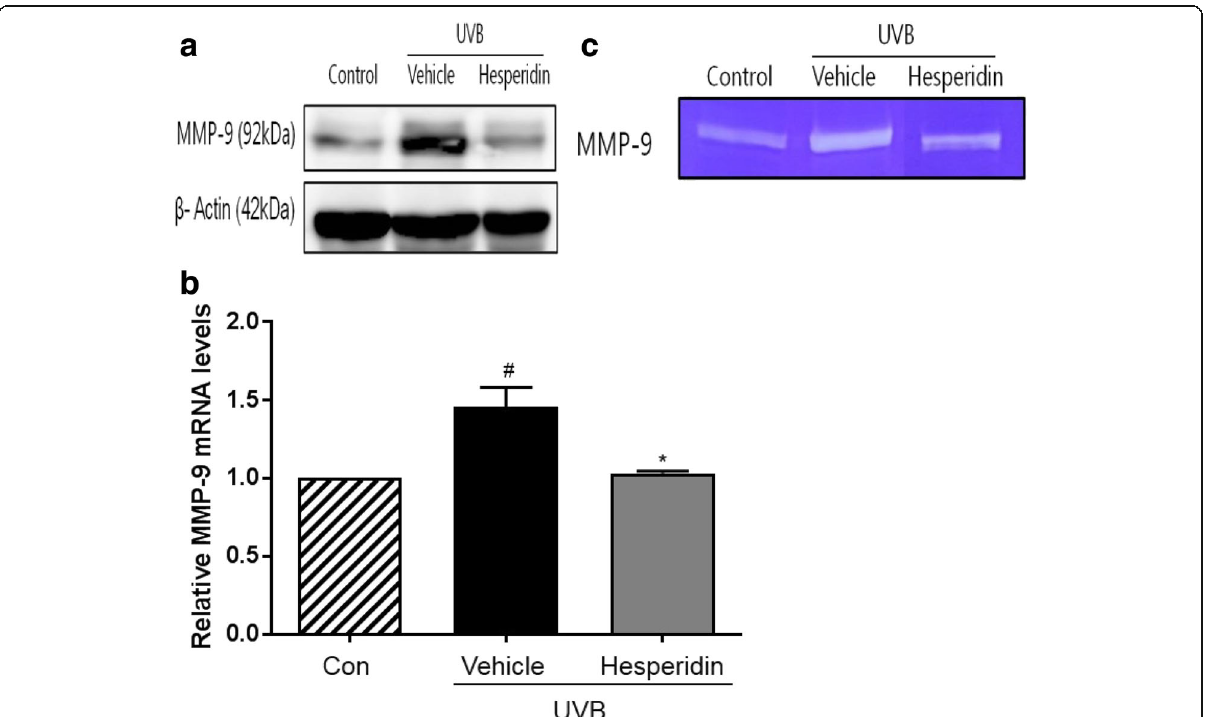
Fig. 4 Inhibitory activity of hesperidin on the UVB-induced MMP-9 protein expression and enzyme activity in the photoaged hairless mice model. ( a ) Inhibition of the UVB-induced MMP-9 protein expression by hesperidin. The MMP-9 levels were determined by western blotting analysis. ( b ) The mRNA MMP-9 levels were determined by RT-PCR. ( c ) Inhibition of MMP-9 activity was measured by gelatin zymography. # P < 0.05 significant difference from control and * P < 0.05 significant difference from UVB/vehicle